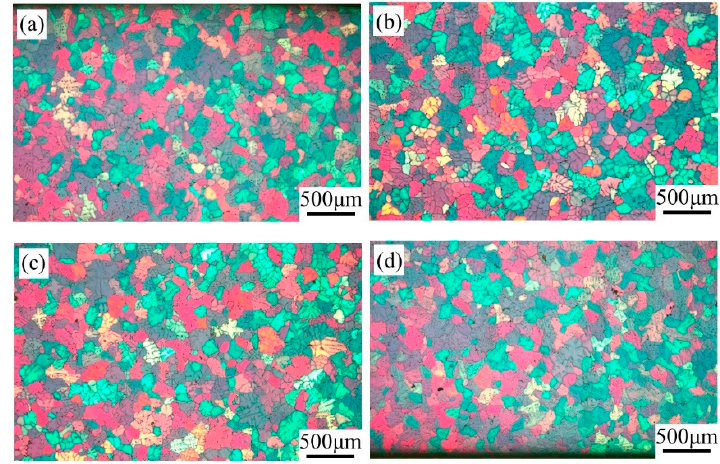
Figure 4. Microstructures of as-cast AA6063 at the locations of ( a ) outer arc surface, ( b ) quarter, ( c ) center and ( d ) inner arc surface.